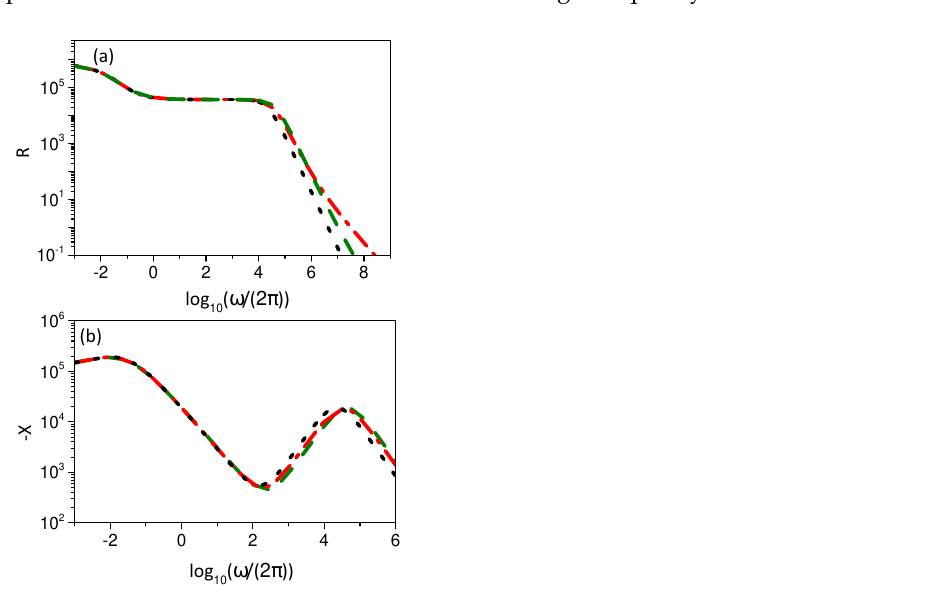
Figure 3. ( a ) Real and ( b ) imaginary parts of the impedance obtained from Equation (48) for different values of γ , with Φ ( i ω ) = p ( i ω ) + ( 1 − p )( i ω ) γ (with p = const ) and k ( i ω ) = κ α ( i ω ) α + κ α (cid:48) ( i ω ) α (cid:48) (with κ = const , α = 0.8, and α (cid:48) = 0.1). The black (dotted), green (dashed), and red (dashed-dotted) lines correspond to the cases γ = 1.0, γ = 0.9 (with p = 1/2), and γ = 0.7 (with p = 1/2), respectively. We consider, for illustrative purposes, D = 2.0 × 10 − 9 m 2 /s, S = 3.14 × 10 − 4 m 2 , ε = 90 ε 0 ( ε 0 = 8.85 × 10 − 12 F/m), d = 1.33 × 10 − 3 m, τ = 1s, κ α = 1.11 × 10 − 6 m/s 1 − α , κ α (cid:48) = 3.00 × 10 − 7 m/s 1 − α (cid:48) , and λ = 1.19 × 10 − 7 m.